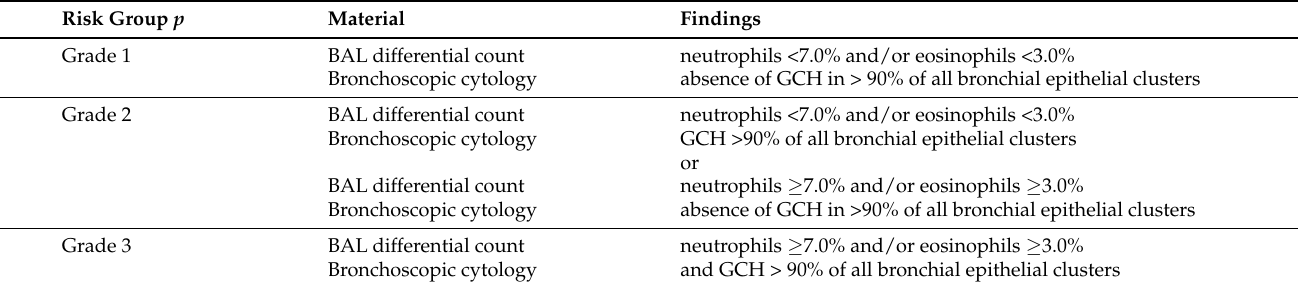
Table 6. Stratification of pulmonary morbidity of cancer-free coal workers’ pneumoconiosis patients by bronchoscopic exfoliative